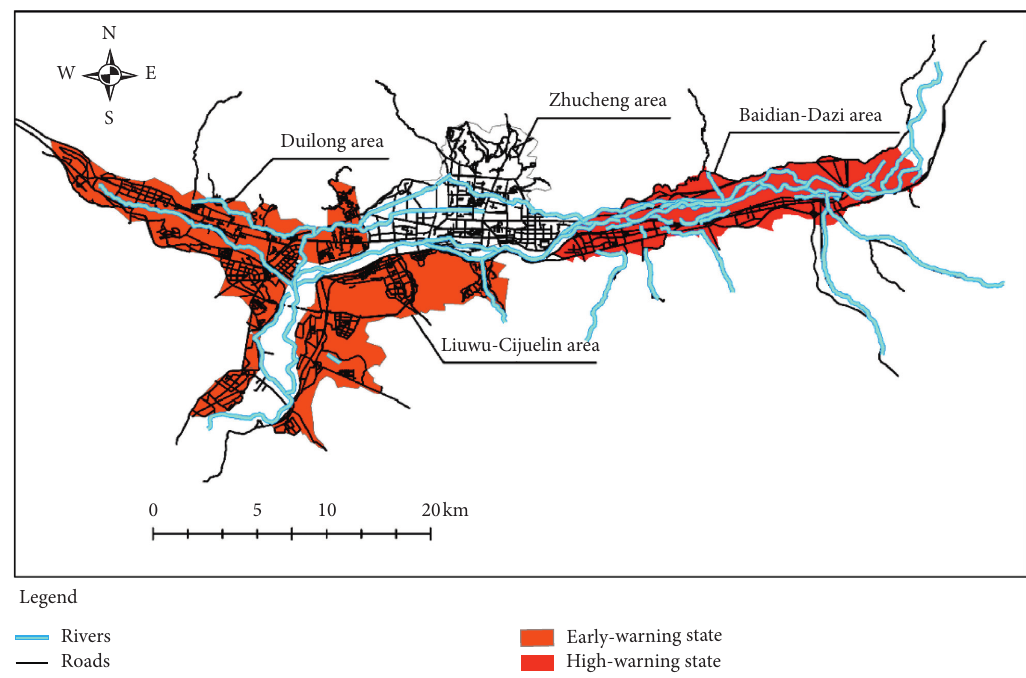
Figure 2: The warning status of Lhasa’s comprehensive travel